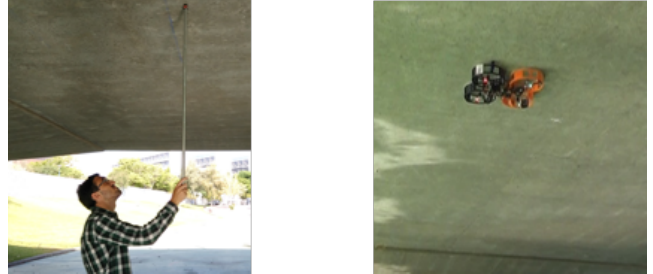
Figure 2. Inspection by manual contact task vs. with an Unmanned Aerial Vehicle